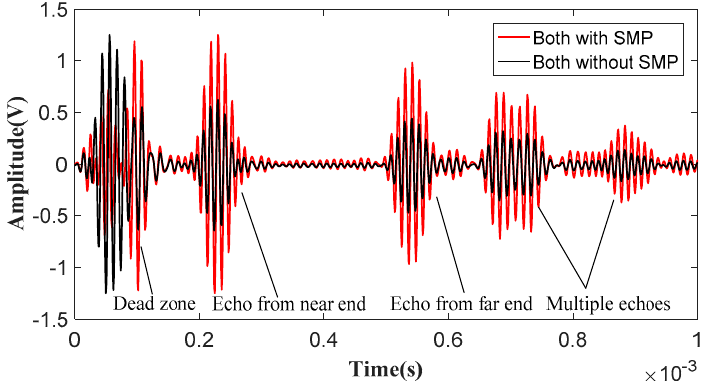
Figure 14. Original signals of the cases in which T1 and T2 both were with and without the SMPs at 85 kHz. T1 was an actuator and T2 was a sensor.